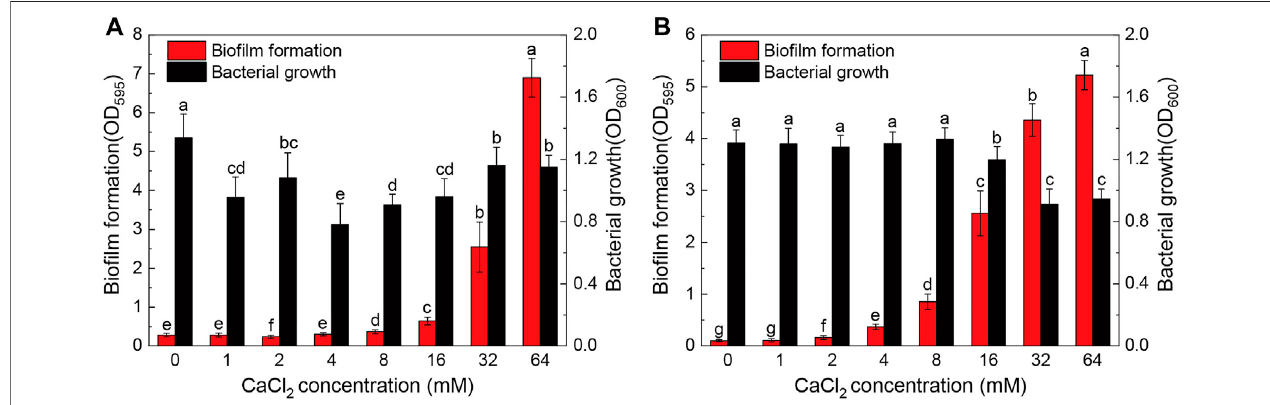
FIGURE 1 | Bio fi lm formation and bacterial growth of Pseudomonas sp. ZX01 (A) and Arthrobacter sp. ZX07 (B) in 12-well microtiter plates when adding different concentrations of CaCl 2 into the medium. Bars represented mean ± standard deviation. Different lowercase letters labeled on the bars represented the signi fi cant difference ( p < 0.05) according to the one-way ANOVA and multiple